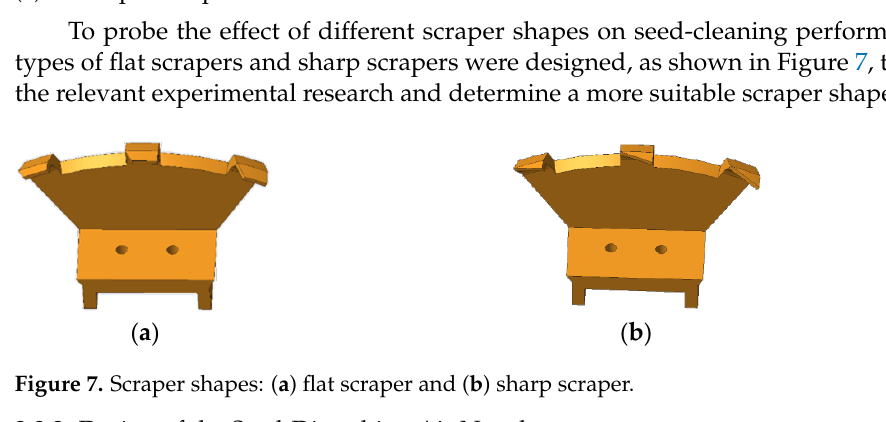
Figure 8. Design of the inclination angle of the central axis of the outlet section of the seed-disturbing air nozzle: ( a ) front view and ( b ) top view. Note: C , intersection of the outer circle and the outermost edge of the sidewall of the type hole; B , intersection of the straight line CO 3 and the inner circle; D , intersection of a plane passing through point B and perpendicular to the central axis of the seeding plate with the outermost edge of the sidewall of the type hole; Q , highest point of the sidewall of the end surface of the filling hole; T 1 , distance between the gravity center of cotton seed and the